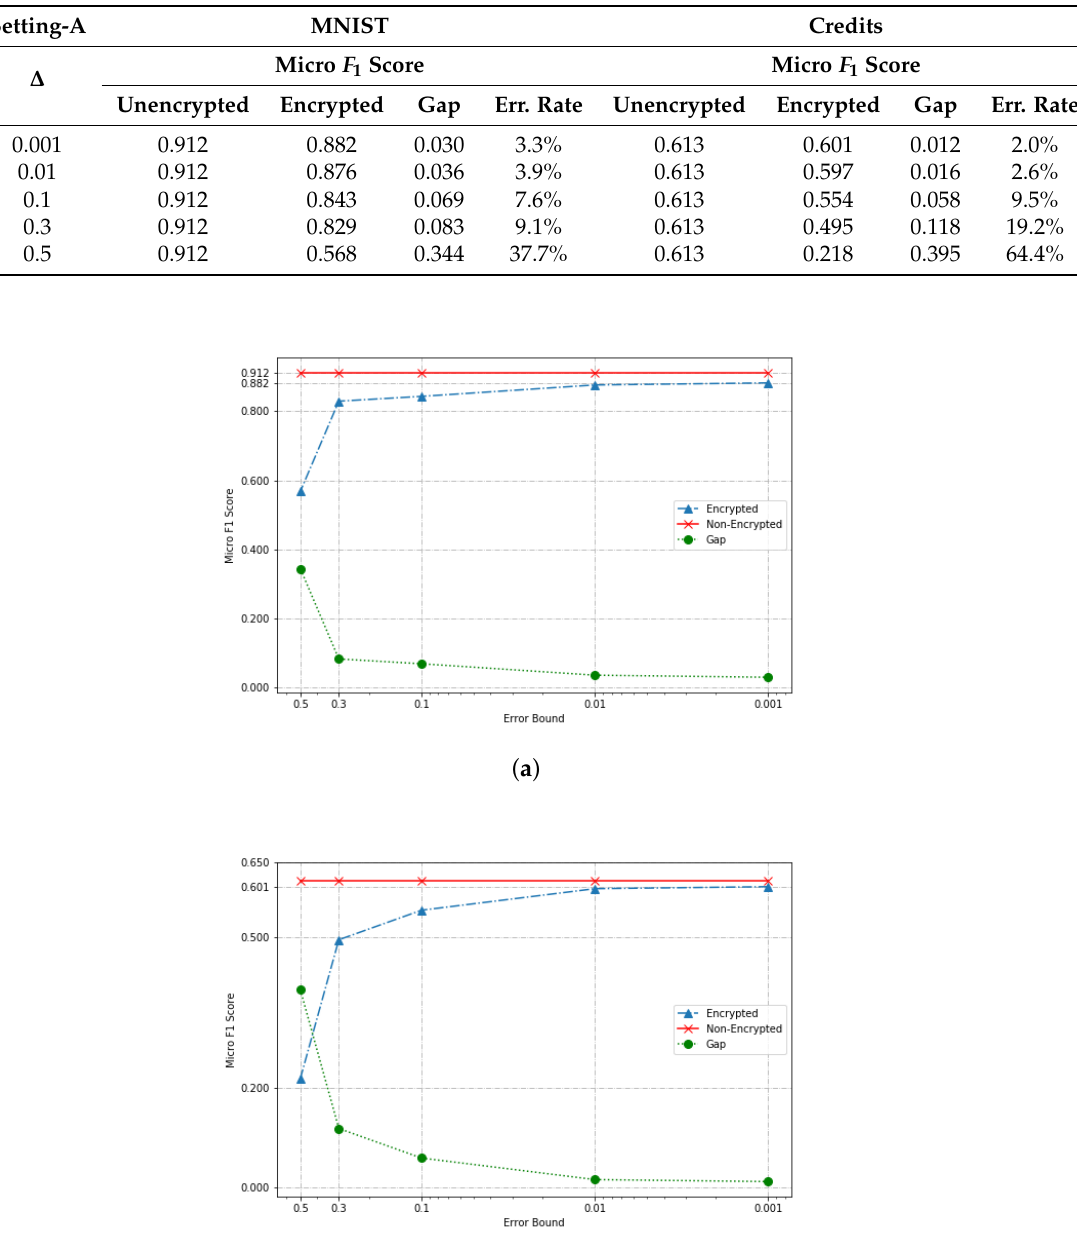
Table 2. Classification performance for various ∆ .